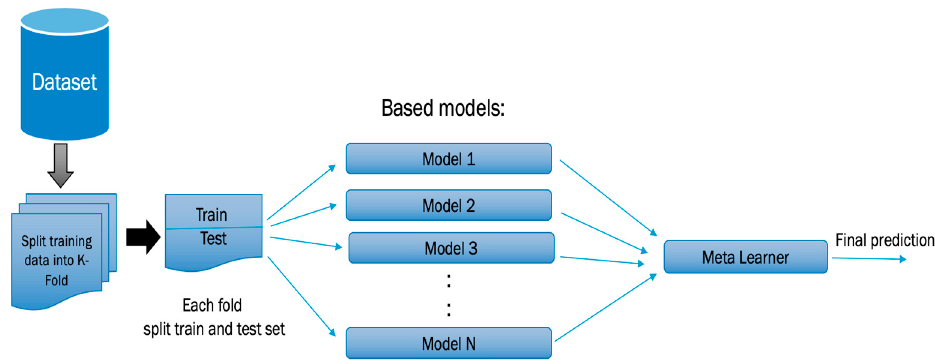
Figure 2. The stacking algorithm flowchart.